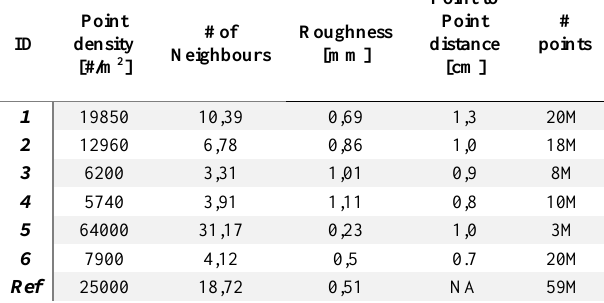
Table 2. Quality metrics analysis for the different